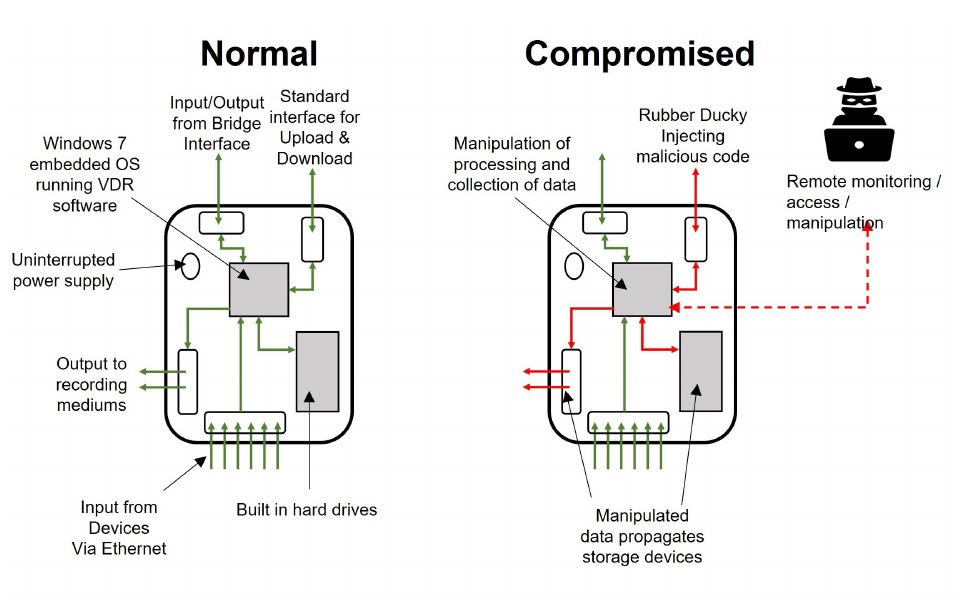
Figure 1. Basic VDR Architecture.